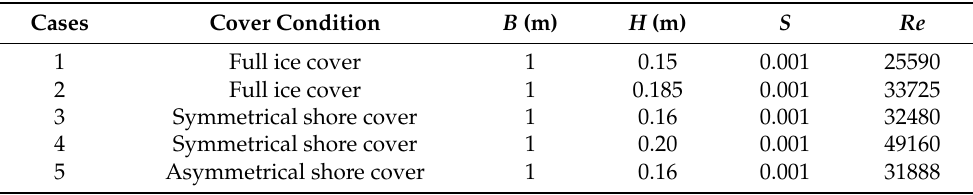
Figure 3. Layout of the measured cross section, lines and points. A 3D acoustic Doppler velocimeter (ADV) with a precision of ± 0.25 cm/s was adopted to measure the instantaneous velocity. The maximum sampling frequency was 50 Hz, and the sampling time for every measured point was 120 s, which resulted in 6000 velocity data for each point. Five experimental conditions were considered here, and the variables 15 to 20 cm. The details of the experimental parameters are listed in Table 1. Table 1. Basic details of the characteristic parameters. 𝐵 is the width of the flume, 𝐻 is the water depth, 𝑆 is the bed slope and 𝑅𝑒 is the Reynolds number.